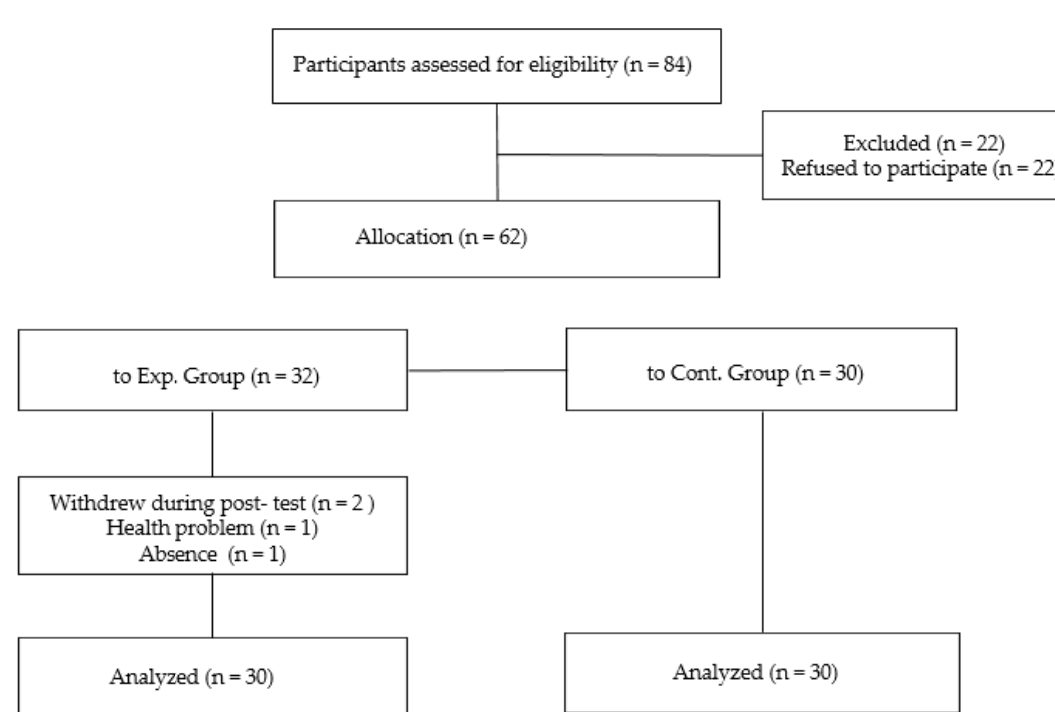
Figure 1. Flow chart of participants’ inclusion.